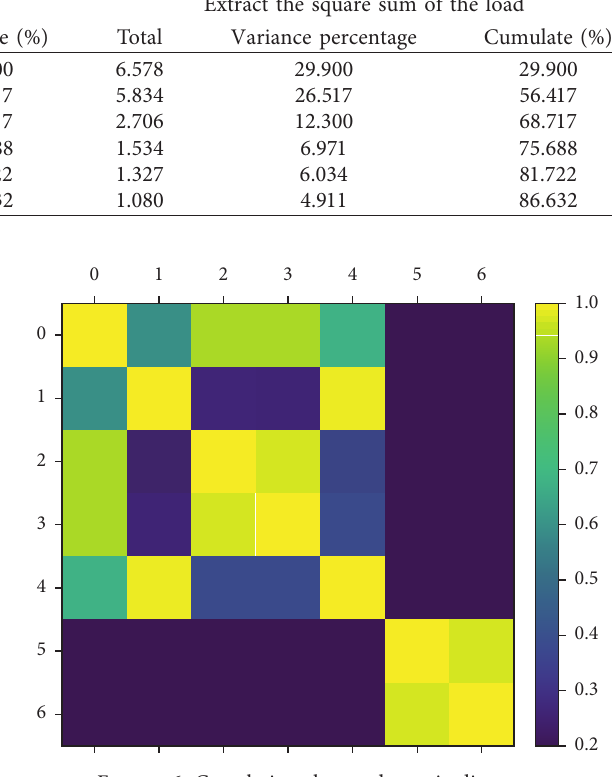
Figure 6: Correlation thermodynamic